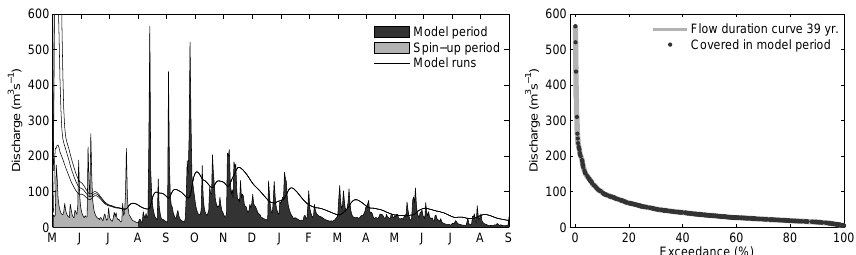
Figure 4. Daily discharge characteristics for the Thur basin. Left panel: the daily discharge in the Thur for the selected model period. The black lines show three model runs with the same parameter set but with different initial conditions ( θ = 0.5, 0.7, 0.9). Right panel: part of the flow duration curve covered within the model period. The flow duration curve is based on 39 years of daily discharge observations in the Thur basin for the period